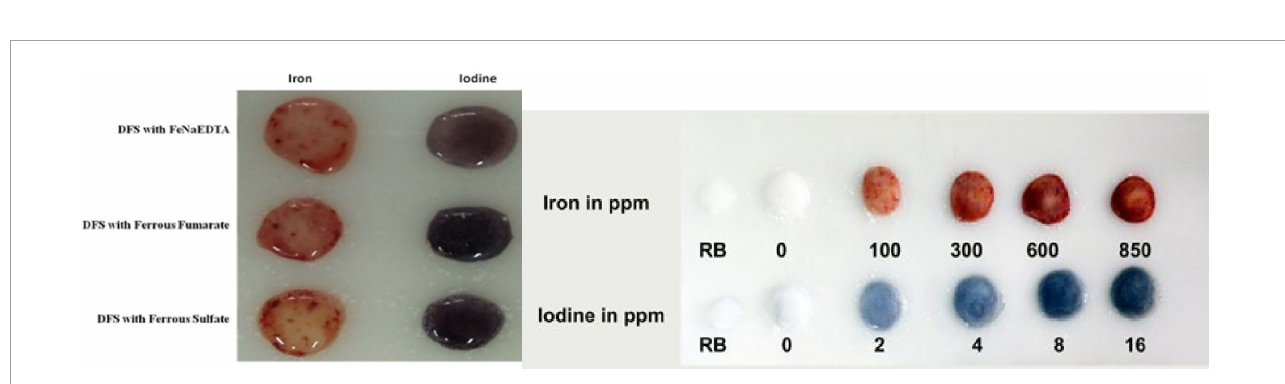
FIGURE2 The kit successfully detects iron from a variety of fortificants as well as iodine in DFS and provides a color gradation chart.